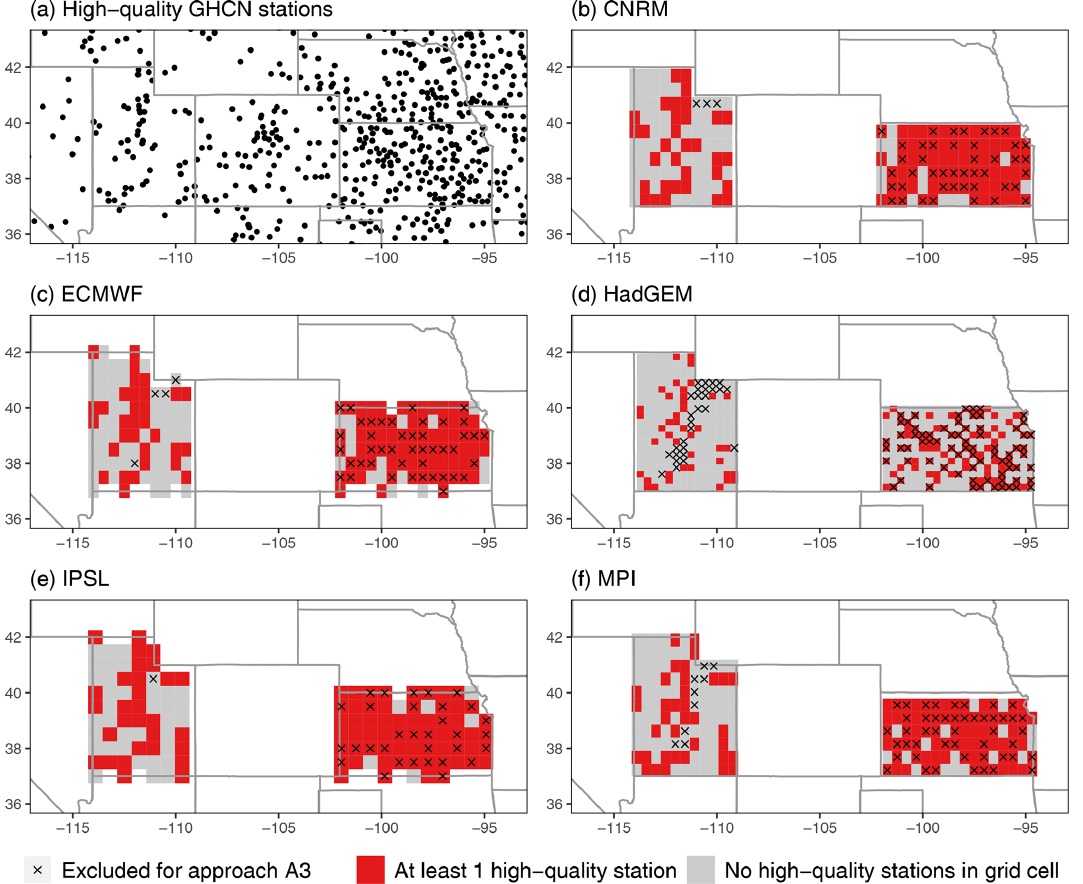
Figure 1. Model grid cells with at least one high-quality GHCN station for Kansas and Utah, with an × denoting model grid cells that are excluded for A3 KS and A3 UT